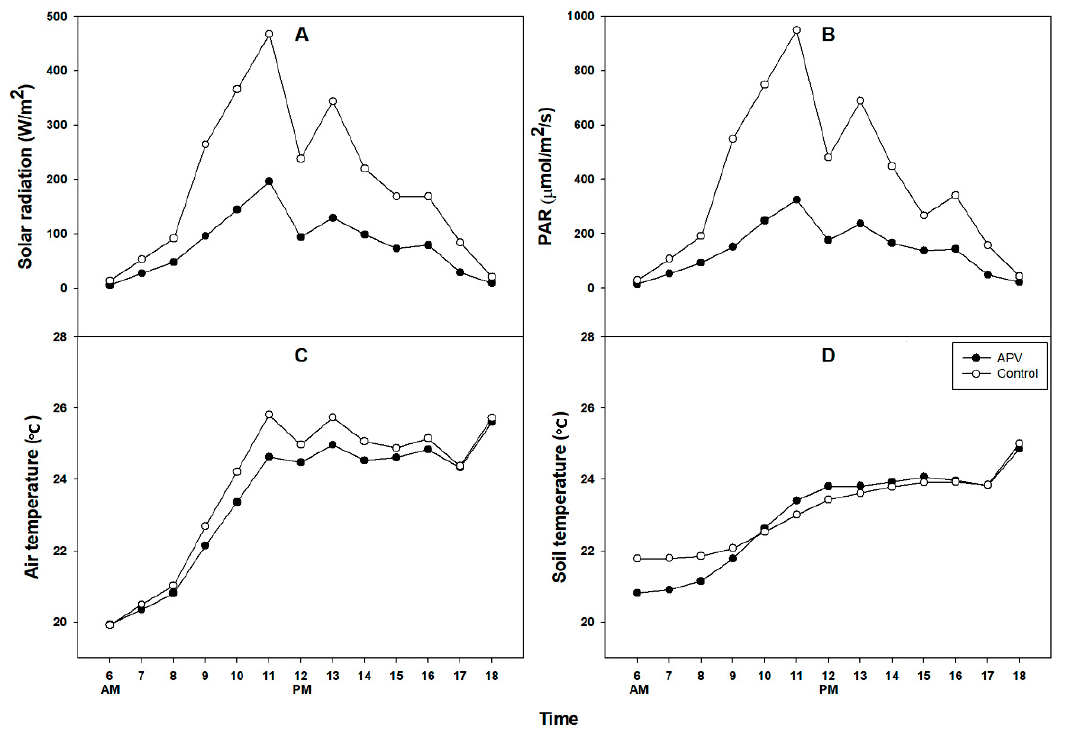
Figure 7. Solar radiation and PAR underneath APV stems in Seungju ( A , September) and Boseong ( B , August), South Korea.